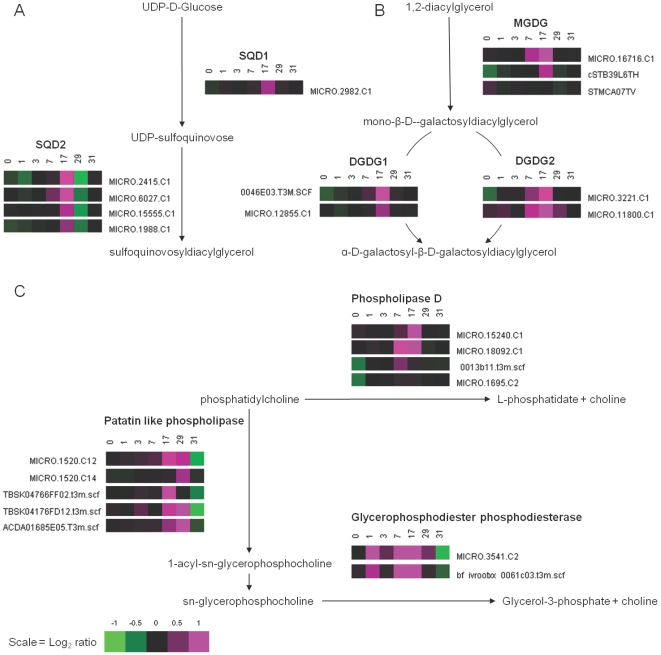
Pathway analysis for sulpho- and galacto-lipid biosynthesis and phospholipid degradation.Expression profiles of transcripts with homology to genes that encode proteins involved in (A) sulpholipid biosynthesis, (B) galactolipid biosynthesis and (C) phospholipid degradation pathways. Pathways were populated with genes using Solanaceae Genomics Network Unigene identifiers and the PotatoCyc pathway tool (http://solcyc.solgenomics.net/expression.html). Numbers above heatmaps are time-points relative to the withdrawal of Pi from the nutrient solution (d), with Pi being re-supplied to the nutrient solution after 28 d.